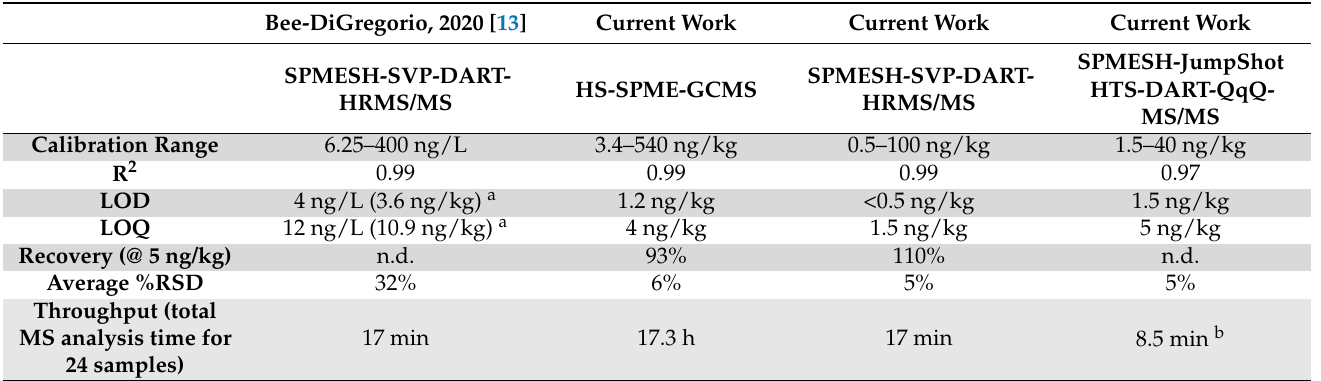
Table 1. Figures of merit for SPMESH-DART-MS/MS of IBMP in grape